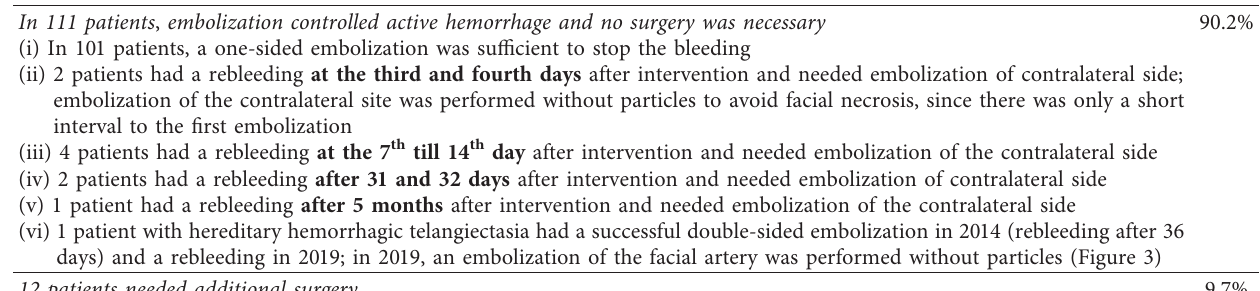
Table 4: Outcome of patients in a follow-up period of at least 6